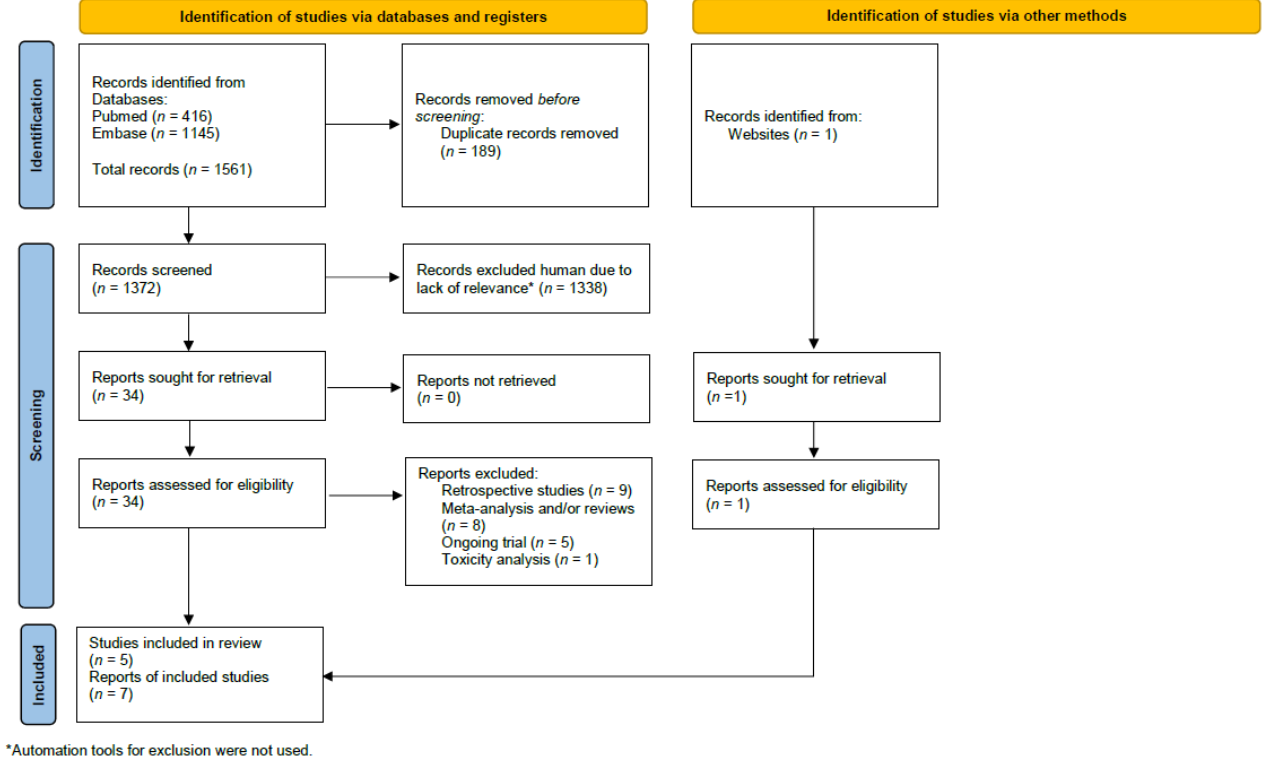
Figure 1. The study selection schema.